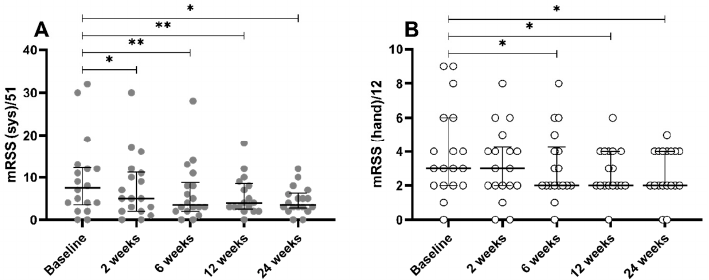
Figure 2. Changes of modified Rodnan skin scores. ( A ) Overall scores and ( B ) scores for hands. Bars and whiskers indicate the median values and interquartile ranges, respectively. mRSS, modified Rodnan skin score; sys, systemic. * p < 0.05, ** p < 0.01.